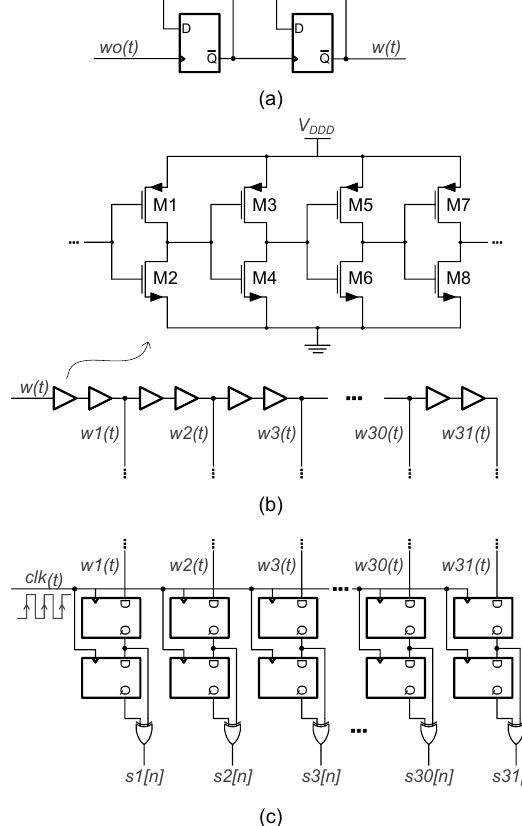
Figure 10. Single-ended digital circuitry of the proposed VCO-ADC: ( a ) Frequency divider; ( b ) 31-stage delay line; ( c ) sampling and demodulation